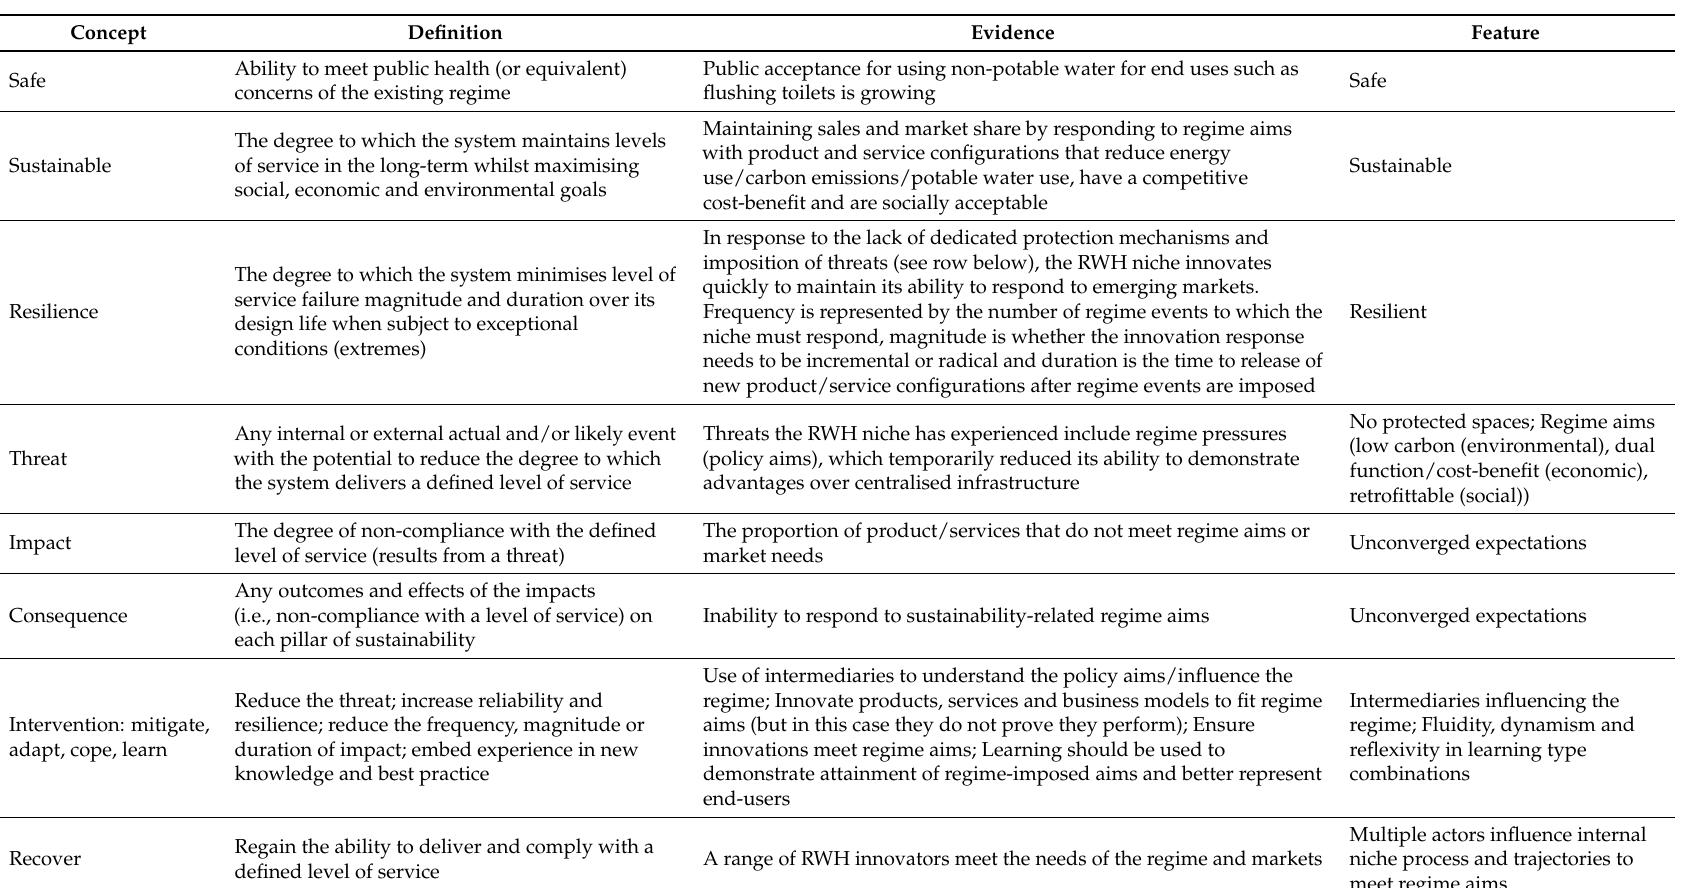
Table 5. Safe, sustainable and resilient framework concepts and definitions, evidence of their fit to the rainwater harvesting network interaction model and niche and their potential niche management